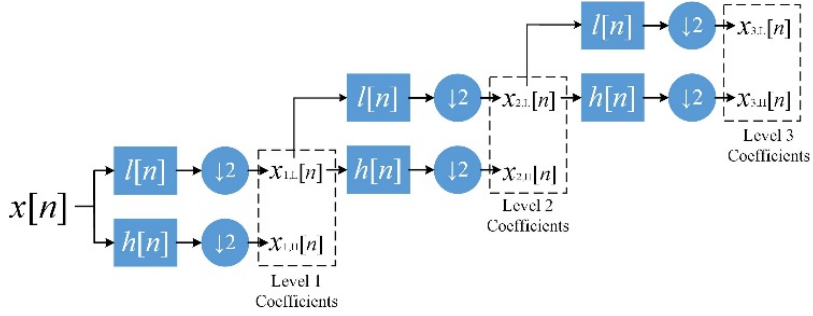
Figure 3. Decomposition process of discrete wavelet transform (DWT).